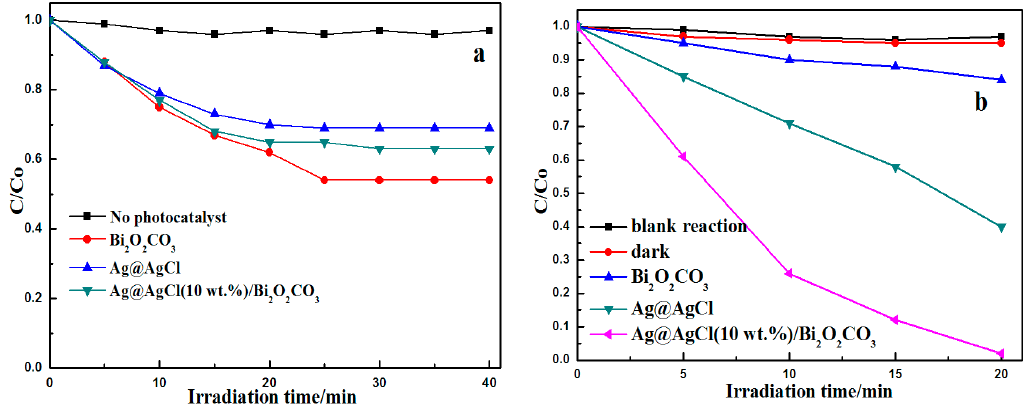
Figure 7. Photocatalytic adsorption ( a ) and degradation ( b ) curves of MB over the various samples.